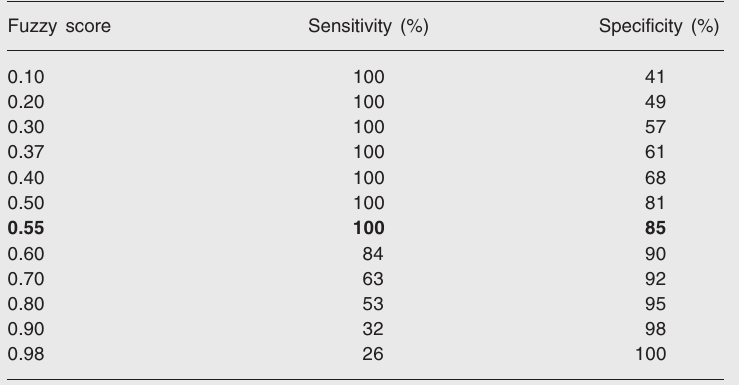
Table 4. Sensitivity and specificity of different fuzzy score thresholds for the selection of patients who should undergo myocardial perfusion